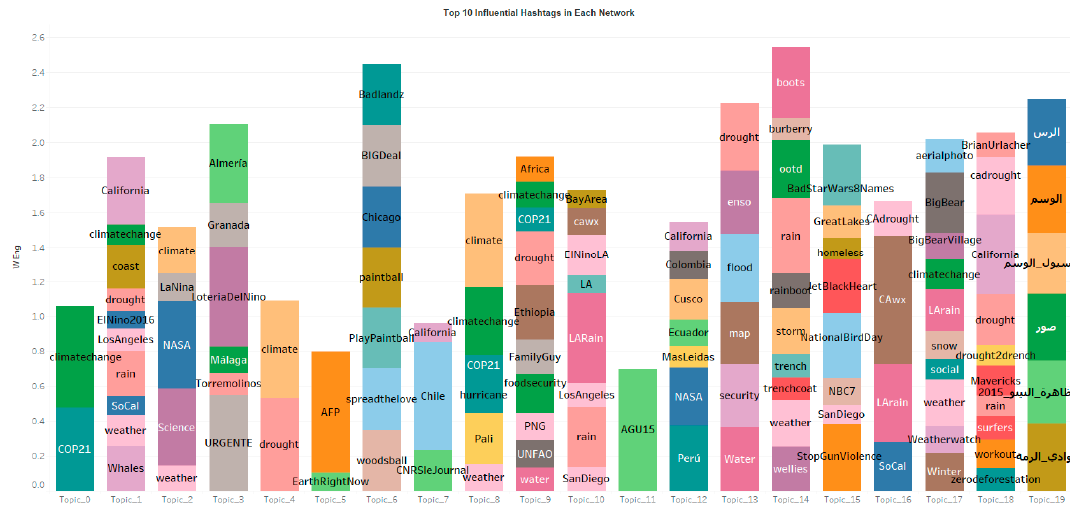
Figure 5. The top 10 influential hashtags (excluding El Niño).